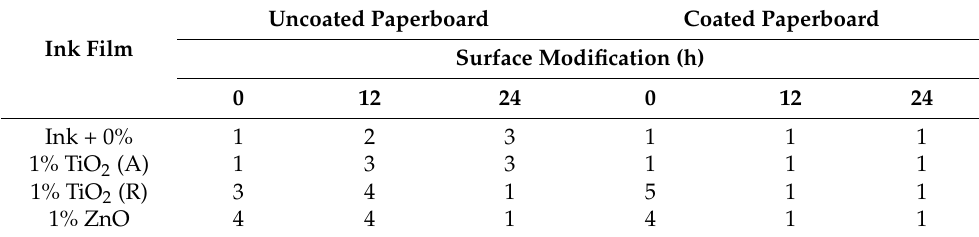
Table 8. Results of the visual assessment of rub resistance on unmodified and modified samples.